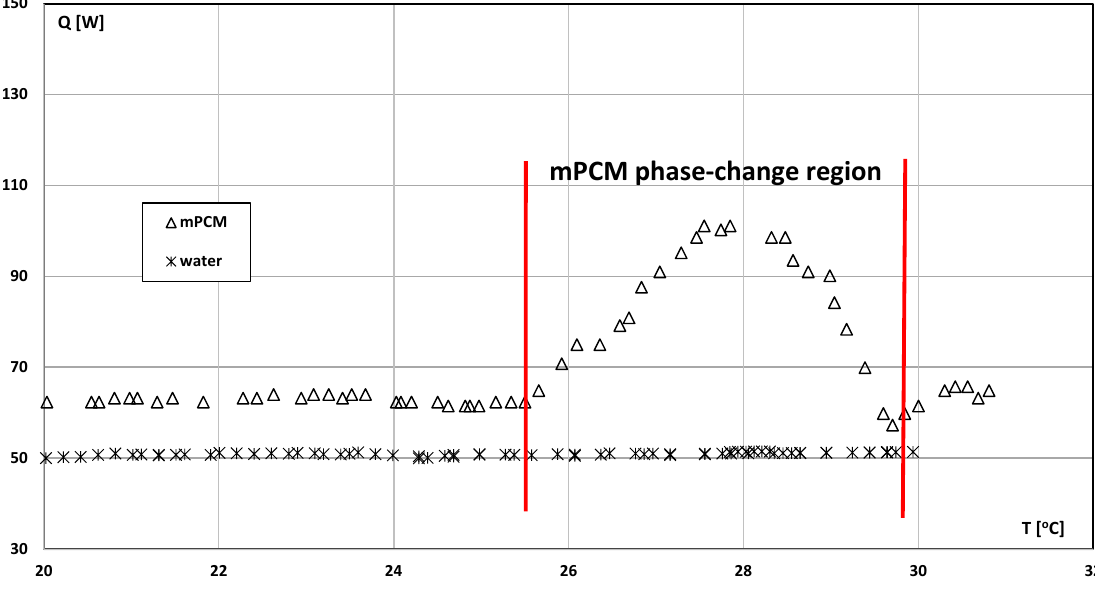
Figure 4. The heat flux versus the inlet temperature of the cooling liquid for pure water and an aqueous solution of water and 10% wt. MPCM.